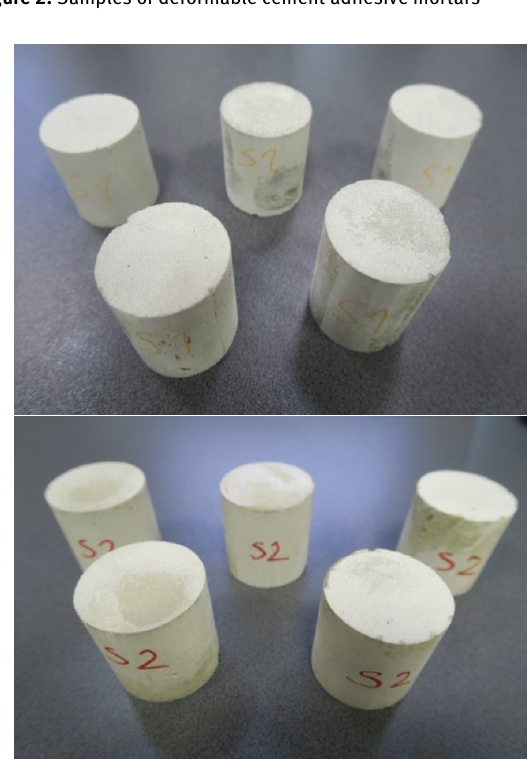
Figure 3: Adhesive mortar samples of type C2S1 and C2S2